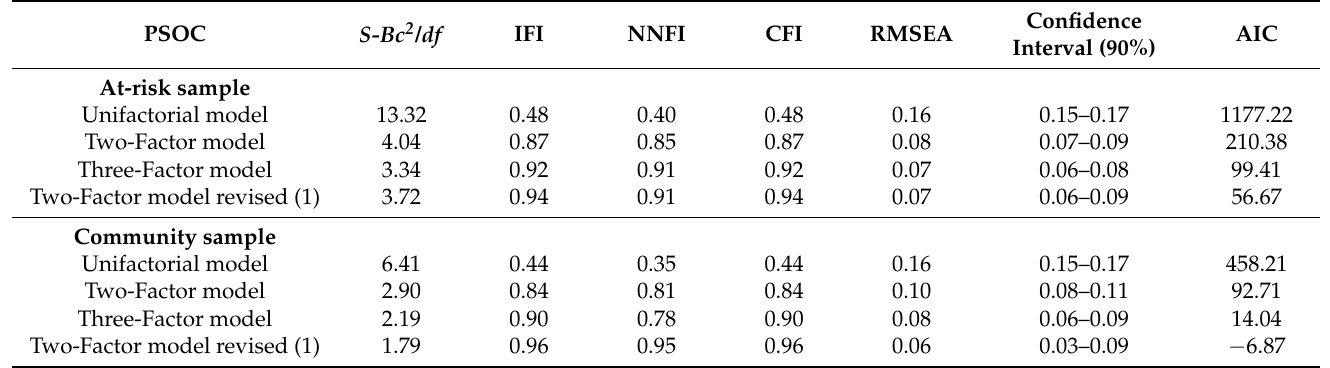
Table 1. Goodness of Fit Indices for Different ML Models of PSOC (at-risk and community sample).